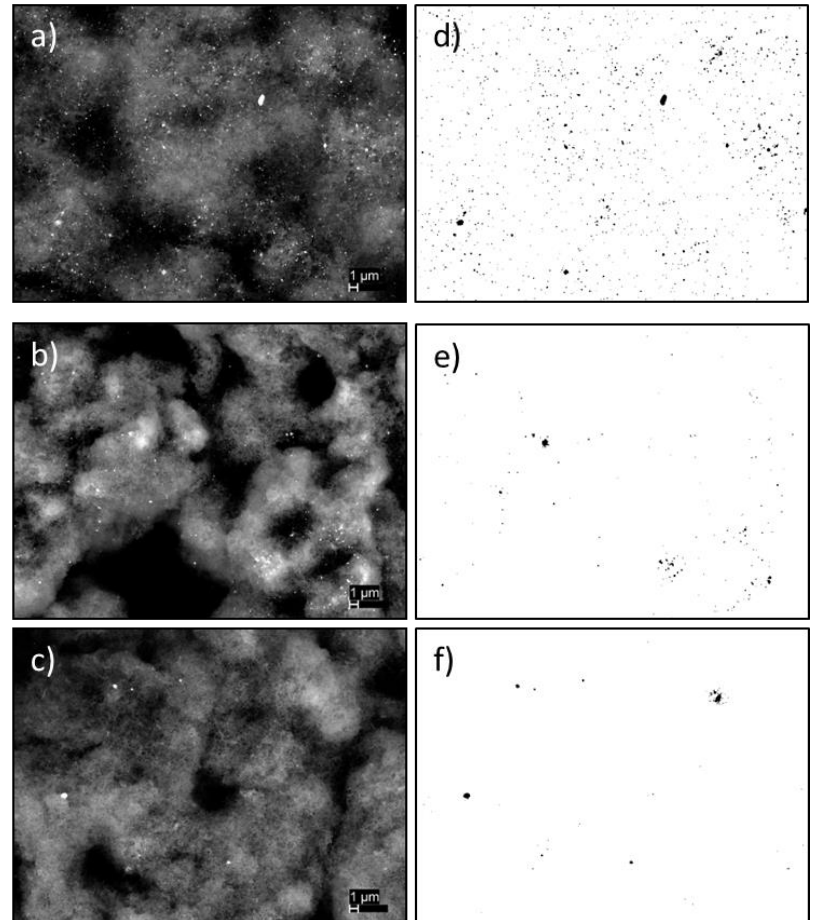
Figure 11. Left: SEM–BSE images of samples treated in an aqueous solution composed of 10% hydrochloric acid and 5% hydrogen peroxide held at 60 °C for ( a ) 0; ( b ) 90, and ( c ) 120 min. Right: Pd regions identified by software ImageJ for samples treated for ( d ) 0; ( e ) 90, and ( f ) 120 min.